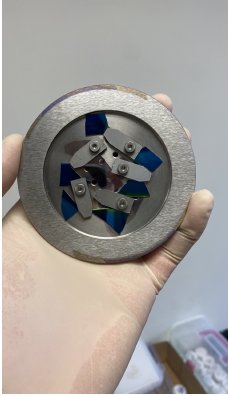
Figure 13. NbN films on a sample holder as they come out from the sputtering machine. The blue sample pieces are 10 nm-thick NbN on the DBR substrate. The gray sample piece shown in the middle is 10 nm-thick NbN grown on the MgO substrate. The difference in color is due to the fine NbN layer